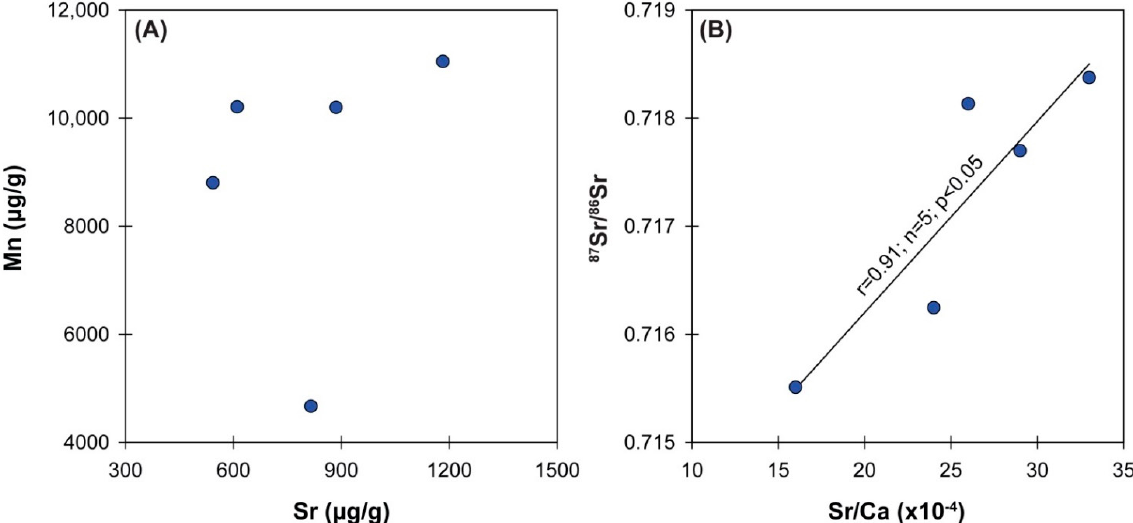
Figure 6. Positive correlations between ( A ) Sr and Mn concentrations, and ( B ) Sr/Ca and 87 Sr/ 86 Sr ratios of the carbonate samples (Mikin Formation) confirm post ‐ depositional alteration of the samples.